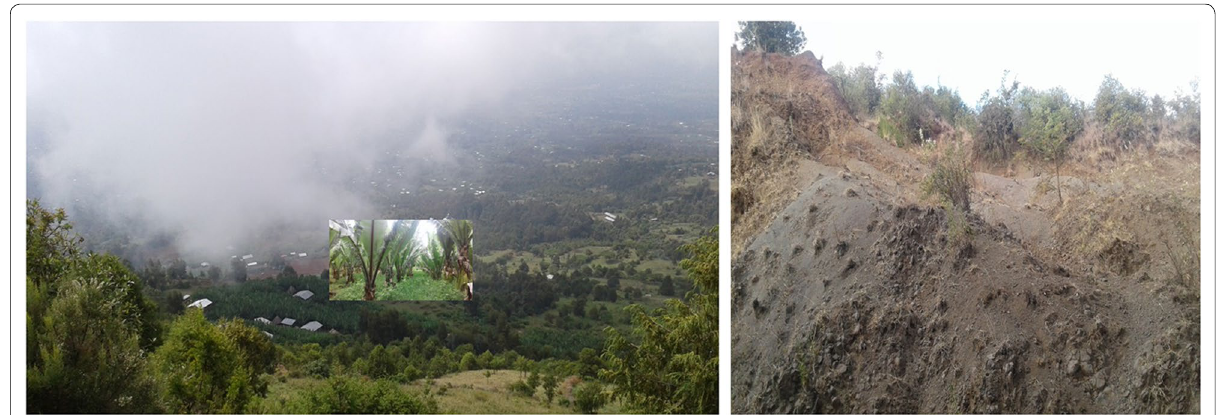
Fig. 4 Land cover in the middle zone of Meki river